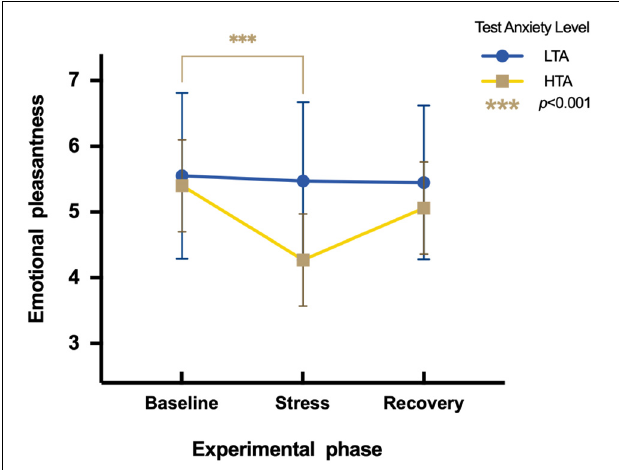
FIGURE 4 | Differences in Ln LF during three experimental phases of HTA and LTA individuals. ∗∗∗ represents a significant difference between the baseline and stress phase of LTA individuals with p -value < 0.001. ∗ represents a significant difference between the baseline and stress phase of HTA individuals with p -value < 0.05.